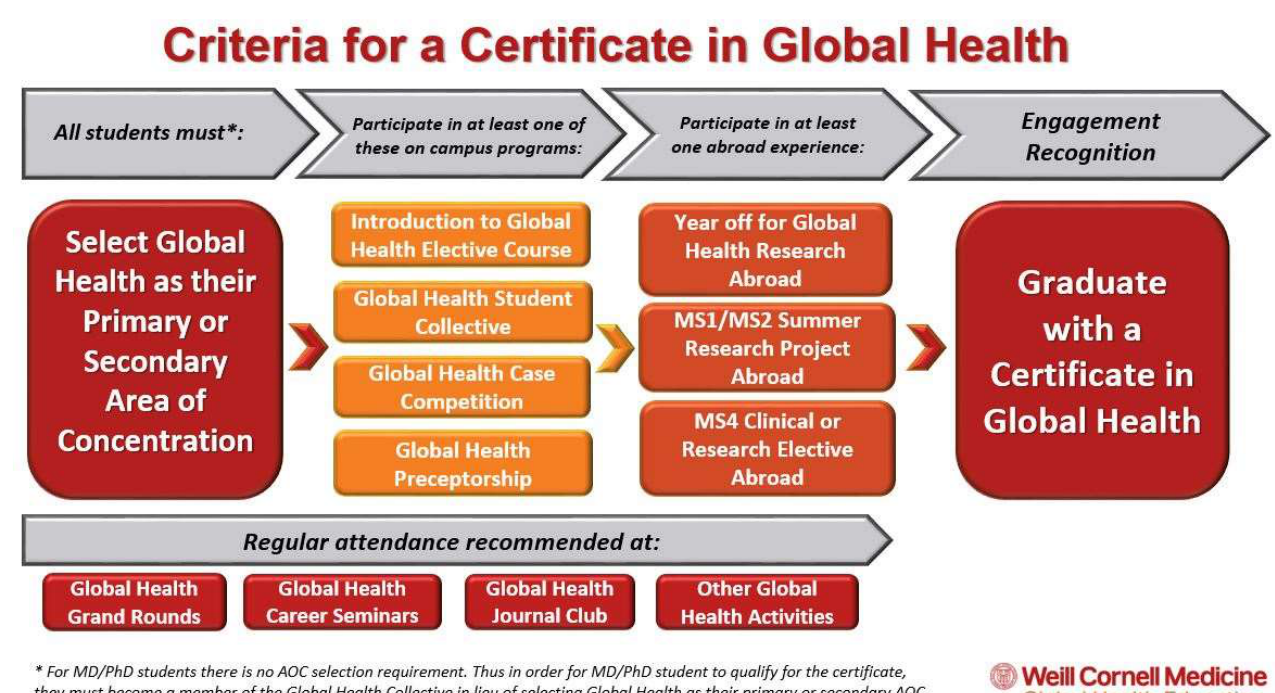
Figure 1 . Requirements to earn a Certificate in Global